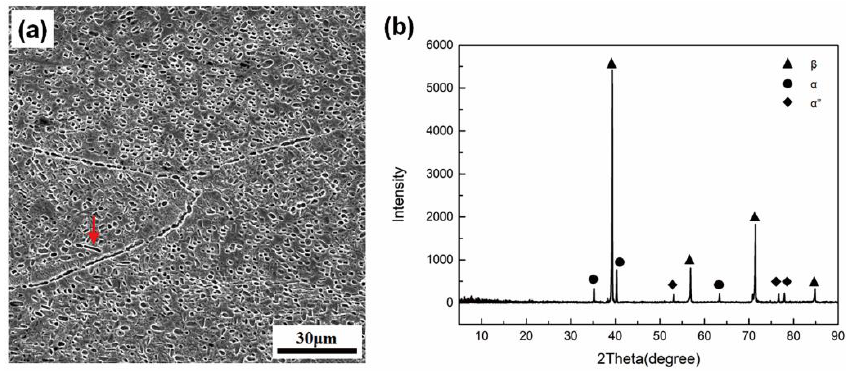
Figure 1. Microstructure of the as-received billet: ( a ) SEM image; ( b ) XRD pattens. Hot compression tests were conducted using a Gleeble 3800 thermomechanical simu- lator. Cylindrical samples, with a dimension of ϕ 10 × 15 mm, were cut from the middle of the billet in the longitudinal direction. Thermocouples were spot-welded at the middle of the samples to measure the temperature change during the deformation process. The samples were heated to deformation temperatures of 650, 700, 750, 800, 820, 850, and 880 ◦ C with a heating rate of 5 ◦ C/s, followed by isothermal holding for 3 min. Subsequently, the samples were compressed with strain rates of 0.001, 0.01, 0.1, 1, and 10 s − 1 , respectively. The height reduction of different samples was constant at about 60% (the true strain was about 0.92). Finally, the samples were water quenched to room temperature to preserve the deformation microstructure at high